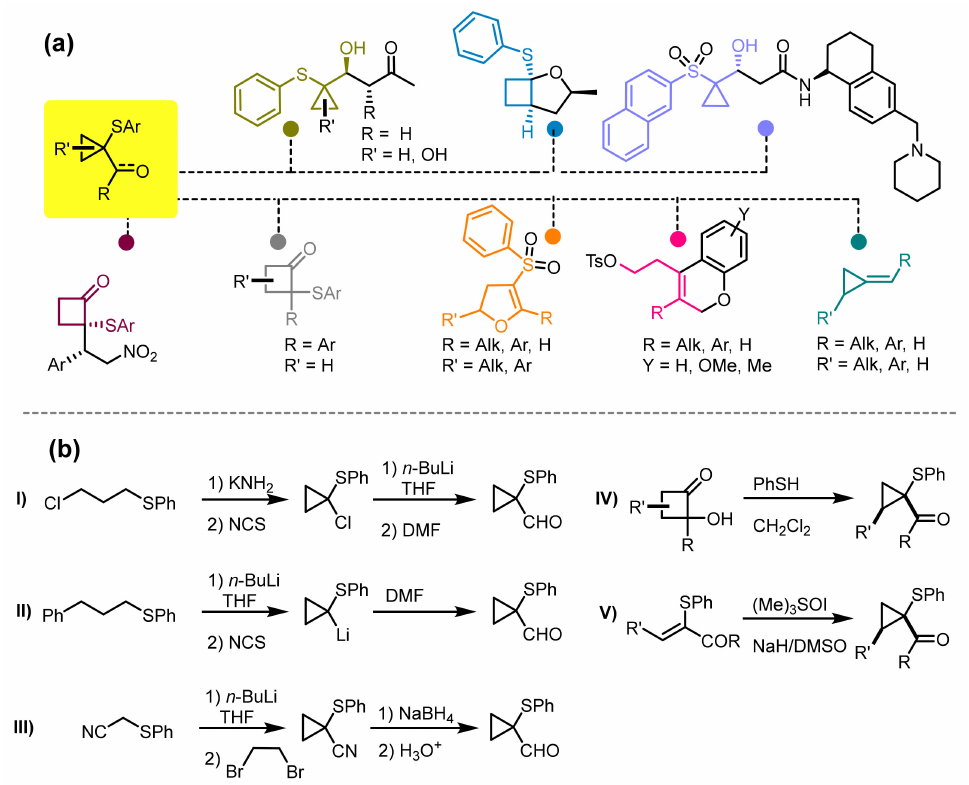
Figure 1. ( a ) Selected synthetic approaches based on the use of arylthiocyclopropyl carbaldehy- des and cyclopropyl ketones for the preparation of complex molecules, phenylthiocyclobutanones and heterocyclic compounds. ( b ) Proposed synthetic procedures for the preparation of arylthiol cyclopropyl carbonyl